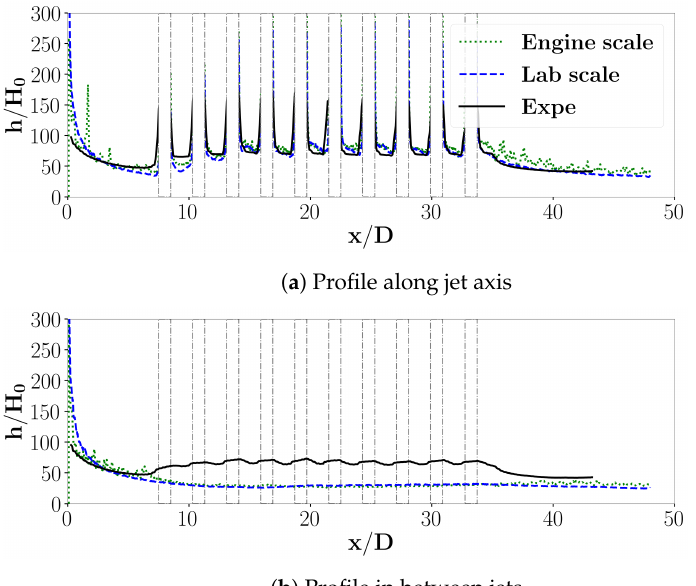
Figure 11. Comparison of time-averaged heat transfer coefficient numerical results for lab scale and engine scale (no turbulence injection) with experimental